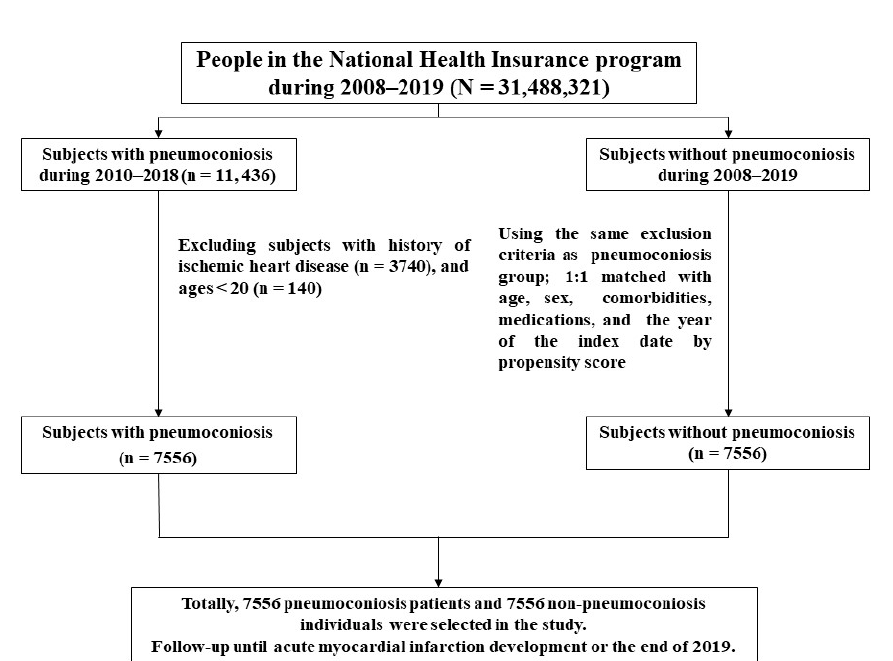
Figure 1. Flowchart of participant selection.